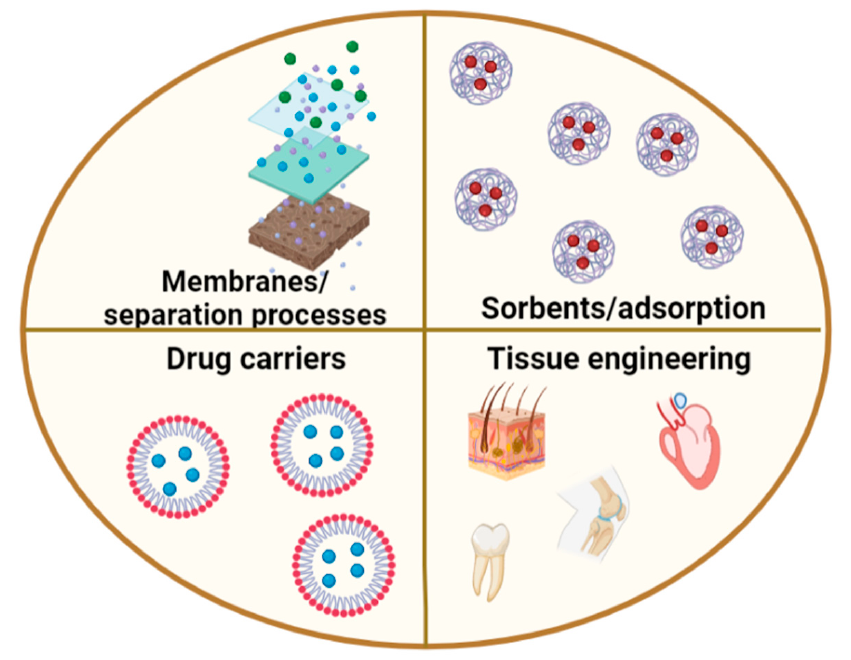
Figure 3. Applications for chitosan materials.